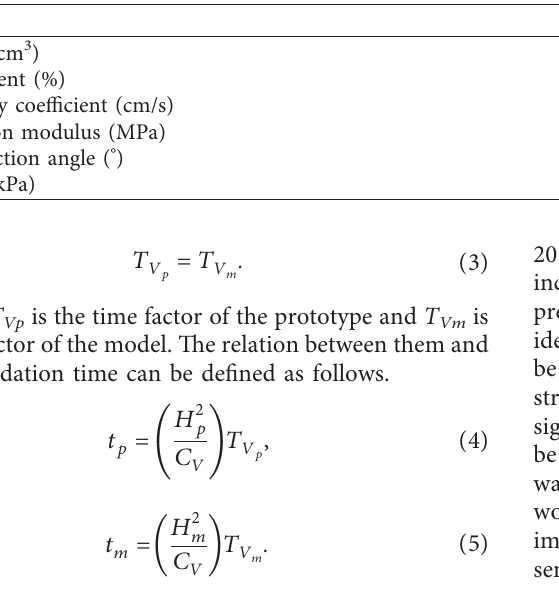
Figure 5: Slope model construction process. Table 1: Key properties of the model soil